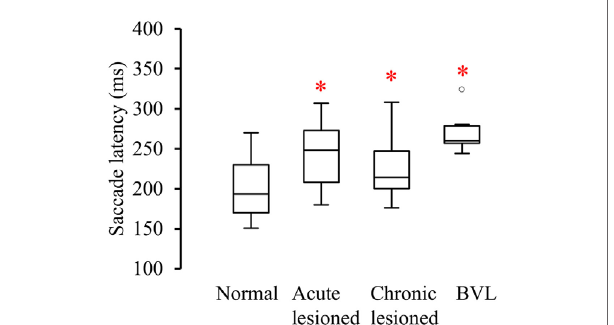
FigUre 6 | latency between the start of head turn and the start of the anti-compensatory saccade (ms) in normal subjects, acute UVl, chronic UVl, and BVl patients . The bottom and the top of the box represent the 25th and 75th percentiles, and the band within the box represents the 50th percentile. The ends of the whiskers represent the maximum and minimum of all the data. Asterisks indicate significantly increased saccade latency in the lesioned side of acute UVL patients ( p < 0.005), the lesioned side of chronic UVL patients ( p < 0.02), and BVL patients ( p <